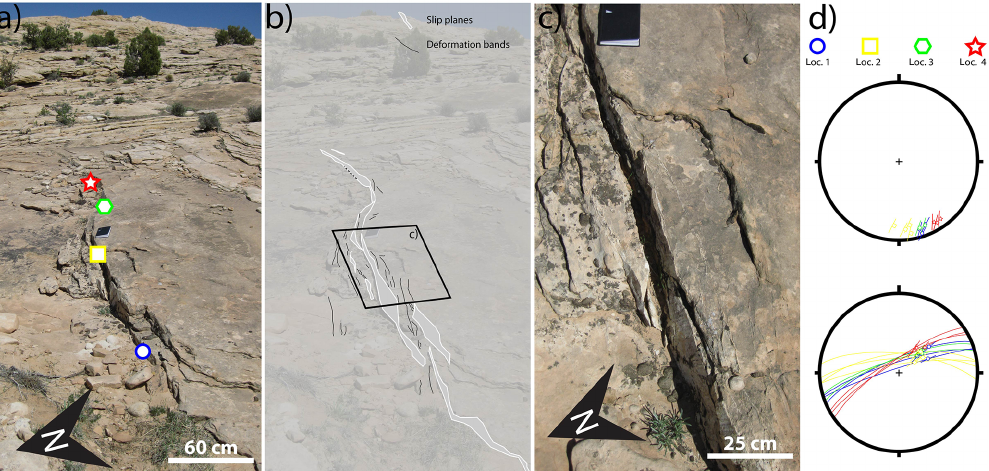
Figure 4. (a) An undulating slip plane in a bundle of deformation bands. Symbols show measurement locations. For location, see Fig. 3 (b) interpreted field image of (a) . (c) Detail of (a) , showing the slip plane in the core of a bundle of deformation bands. (d) Stereographic plot of the orientation and slip direction at the four locations, shown in (a) . In (d) , both the Hoeppener plot (top) and the great circle plot (bottom) show that these locations exhibit significantly different orientations of the structure but that the slip directions are similar. The colours and symbols in (d) correspond to those in (a) .